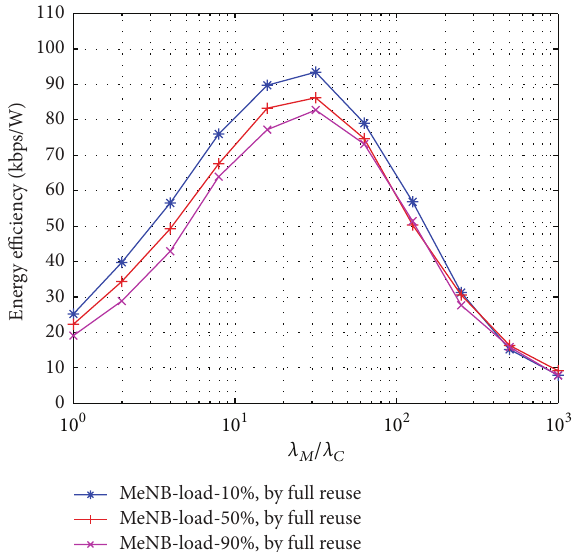
Figure 4: Energy efficiency in cooperative HetNet with different MBS